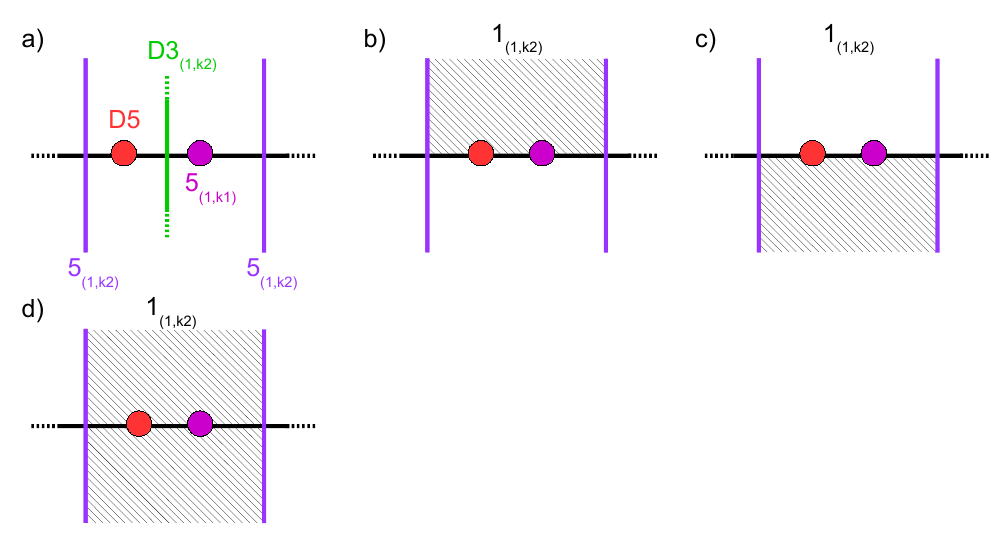
, (c) v (cid:0) , and II II